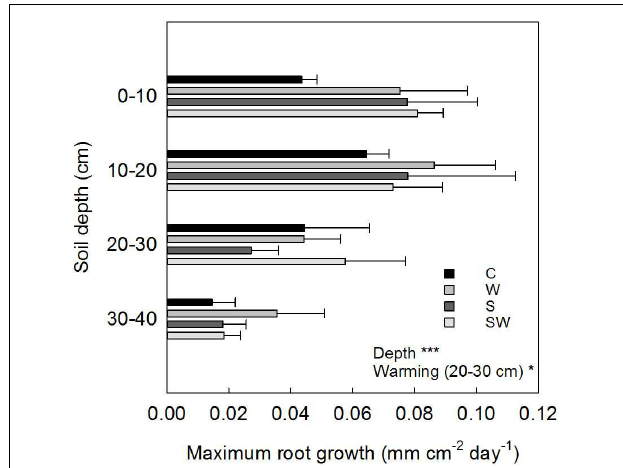
FIGURE 6 | Averaged values estimated for each treatment (mean ± SE) at each soil depth interval of maximum root growth per tube area. Significant treatment effects are indicated by a ∗ P ≤ 0.05 and ∗∗∗ P <